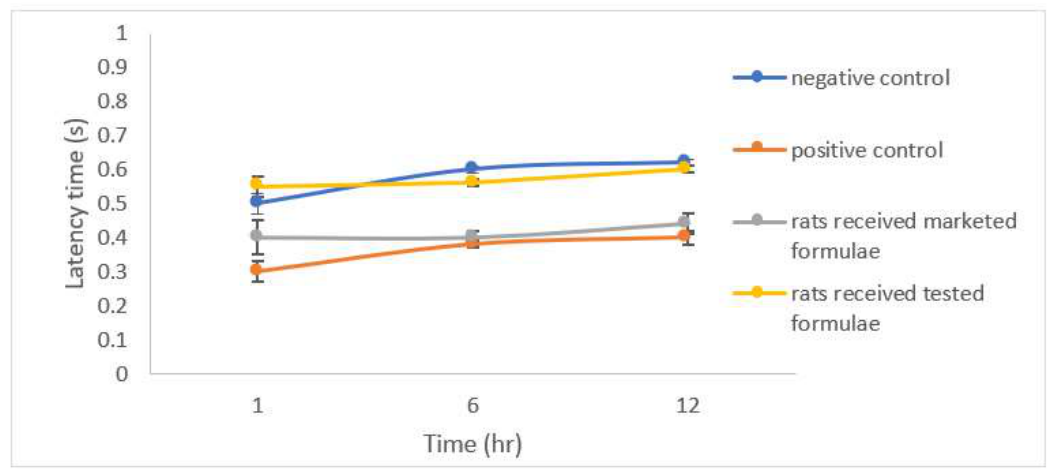
Figure 8. Latency time in by different groups of rats .